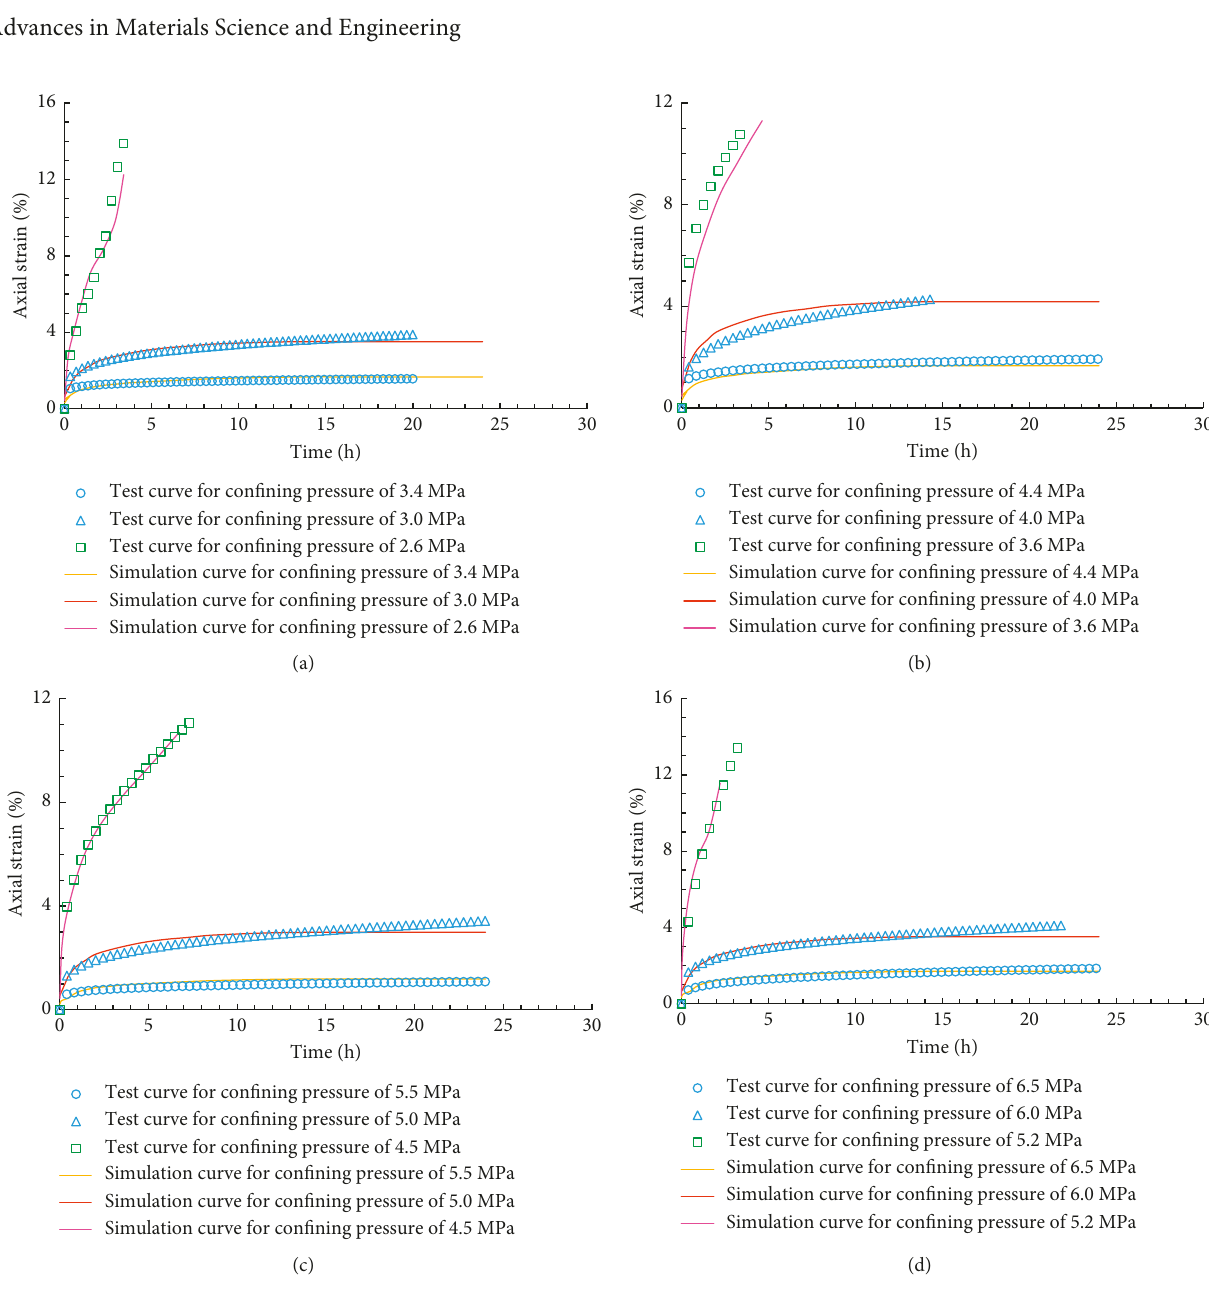
Figure 2: Comparison between measured and theoretical values from triaxial creep tests of artificial frozen soil at different freezing temperature and consolidation confining pressure: (a) − 10 ° C, 4.0 MPa; (b) − 10 ° C, 5.0 MPa; (c) − 10 ° C, 6.0MPa; (d) − 10 ° C,